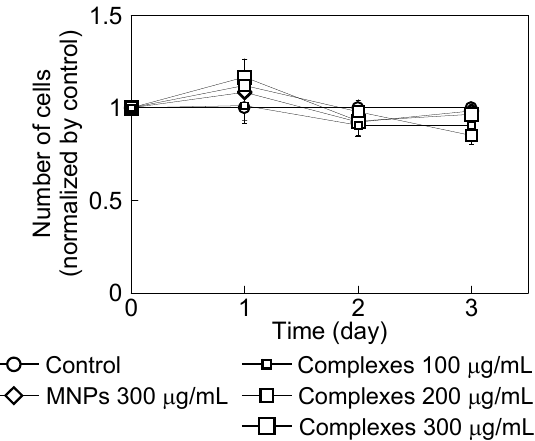
Figure 5. TIG-1 cell growth in the presence of PEI-coated MNPs at 300 μ g/mL and with MNP/antibody complexes at 100, 200 and 300 μ g/mL. The control did not include these treatments. Cell numbers were normalized to the number of control